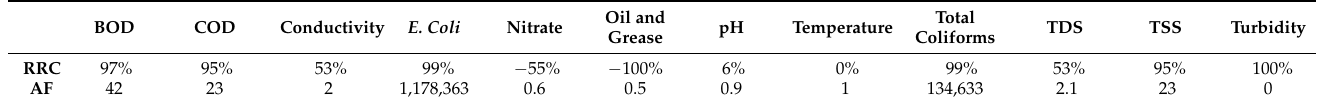
Table 7. River recovery capacity and accumulation factor for physicochemical parameters of Ngong River dry